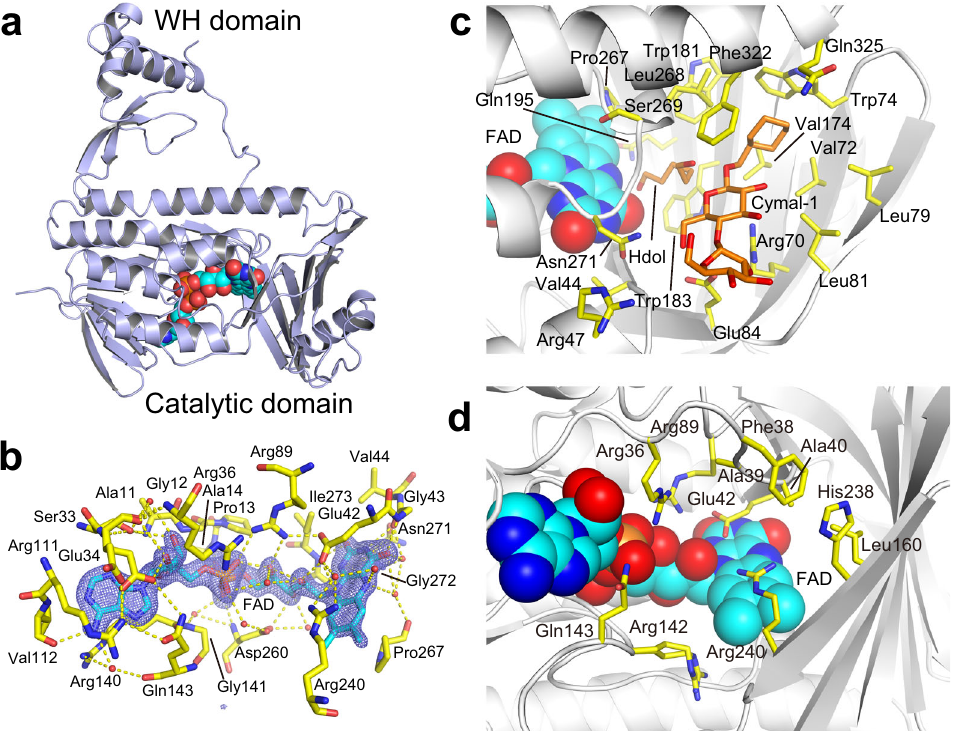
Fig. 6 X-ray crystal structure of QhpG. a Overall structure of QhpG monomer. The monomer structure (chain A) is depicted by a cartoon model with a spherical model of the bound FAD. b Structure of FAD-binding site. A stick model of the bound FAD is shown with the surrounding residues. An F o – F c omit map for FAD, contoured at 5 σ , is depicted by blue mesh. Hydrogen bonds and water molecules are shown by yellow dotted lines and red small spheres, respectively. c , d Channels formed in the re -face ( c ) and si -face ( d ) sides of FAD (in chain B) is shown with stick models of the side chains (yellow) on the white cartoon model of QhpG. 1,6-Hexanediol (Hdol) and cyclohexyl-methyl- β - D -maltoside (Cymal-1) (additives in crystallization buffer) bound to the re - face channel are indicated by orange stick models. FAD is indicated by a spherical